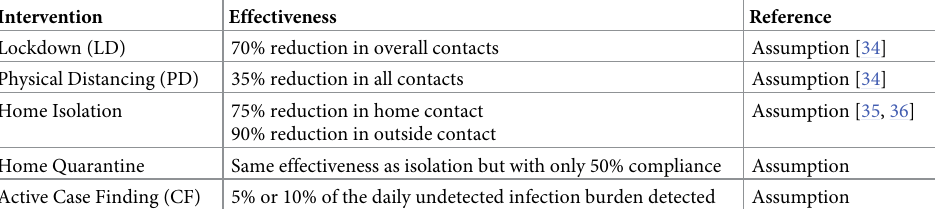
Table 2. Interventions against COVID-19 and their effectiveness.